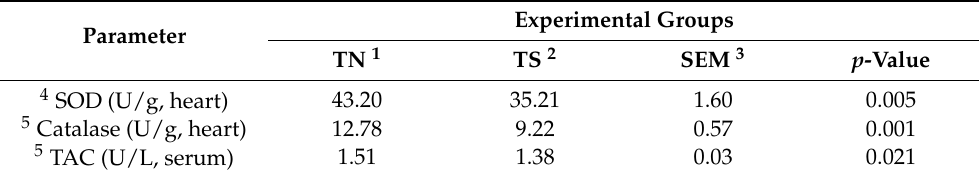
Table 3. Effect of chronic thermal stress on antioxidant activity of broiler chickens. Parameter